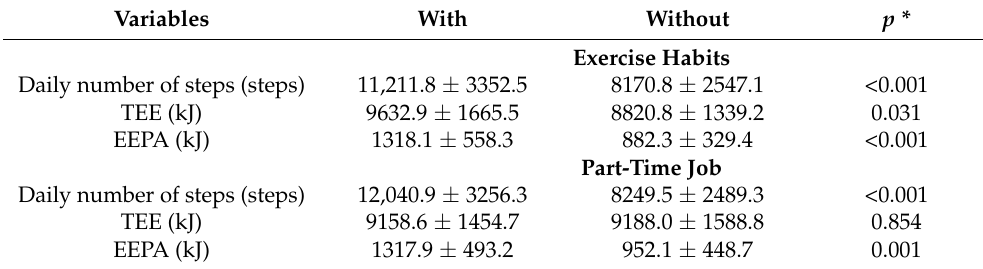
Table 3. Comparison of physical activity levels with and without exercise habits and part-time job. Variables With Without p * Exercise Habits Daily number of steps (steps) 11,211.8 ± 3352.5 8170.8 ± 2547.1